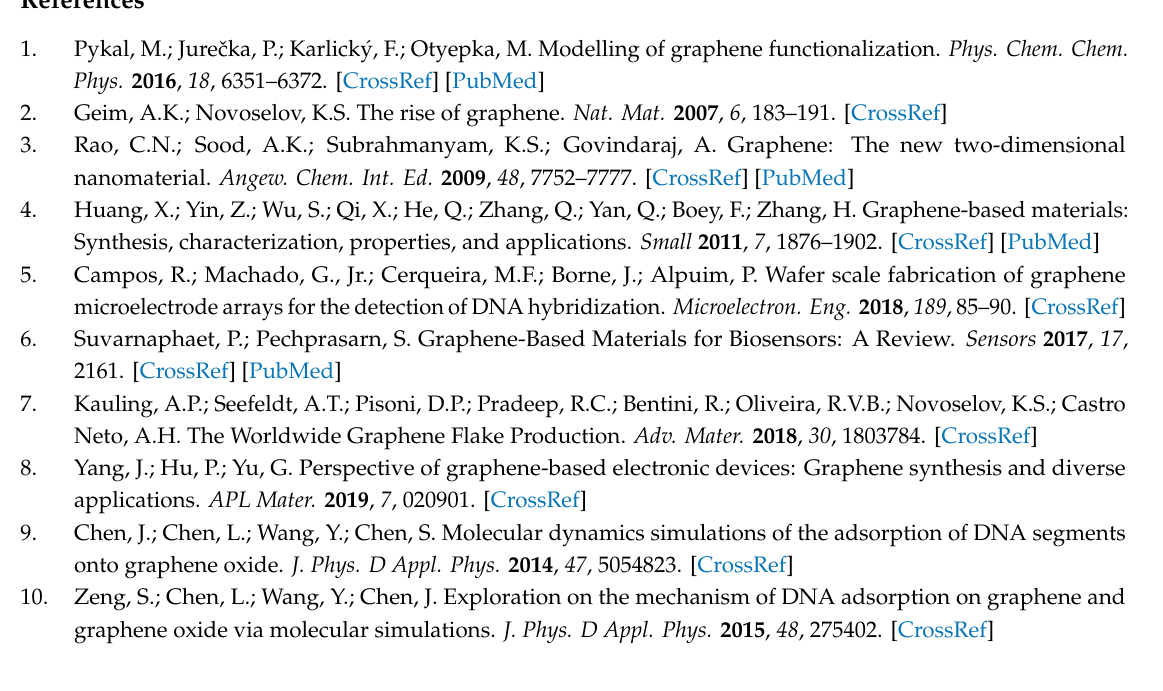
Table S1: The number of Mg 2 + and Cl − ions added in each of the di ff erent setups; Figure S1: Model displaying the chemical formula of the –NH-PEG-NH 2 molecule used in order to create the rGO-PEG-NH 2 graphenic species; Figure S2: Ion distribution at the end of the equilibration step; Figure S3: ssDNA adsorption on rGO-PEG-NH 2 in the presence of Cl- ions; Figure S4: dsDNA adsorption on rGO-PEG-NH 2 in the presence of Cl-